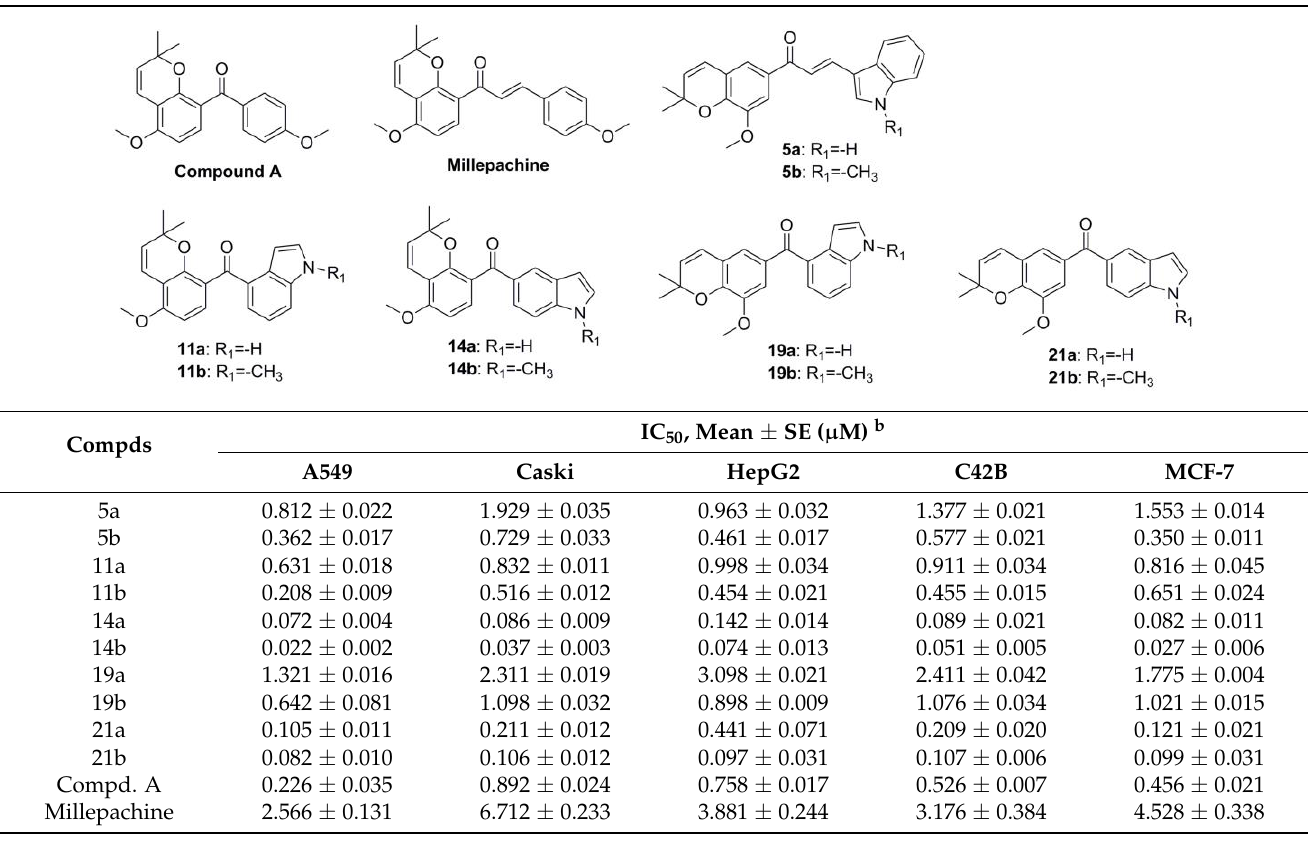
Table 1. The antiproliferative activities evaluated in five kinds of human cancer cell lines a .